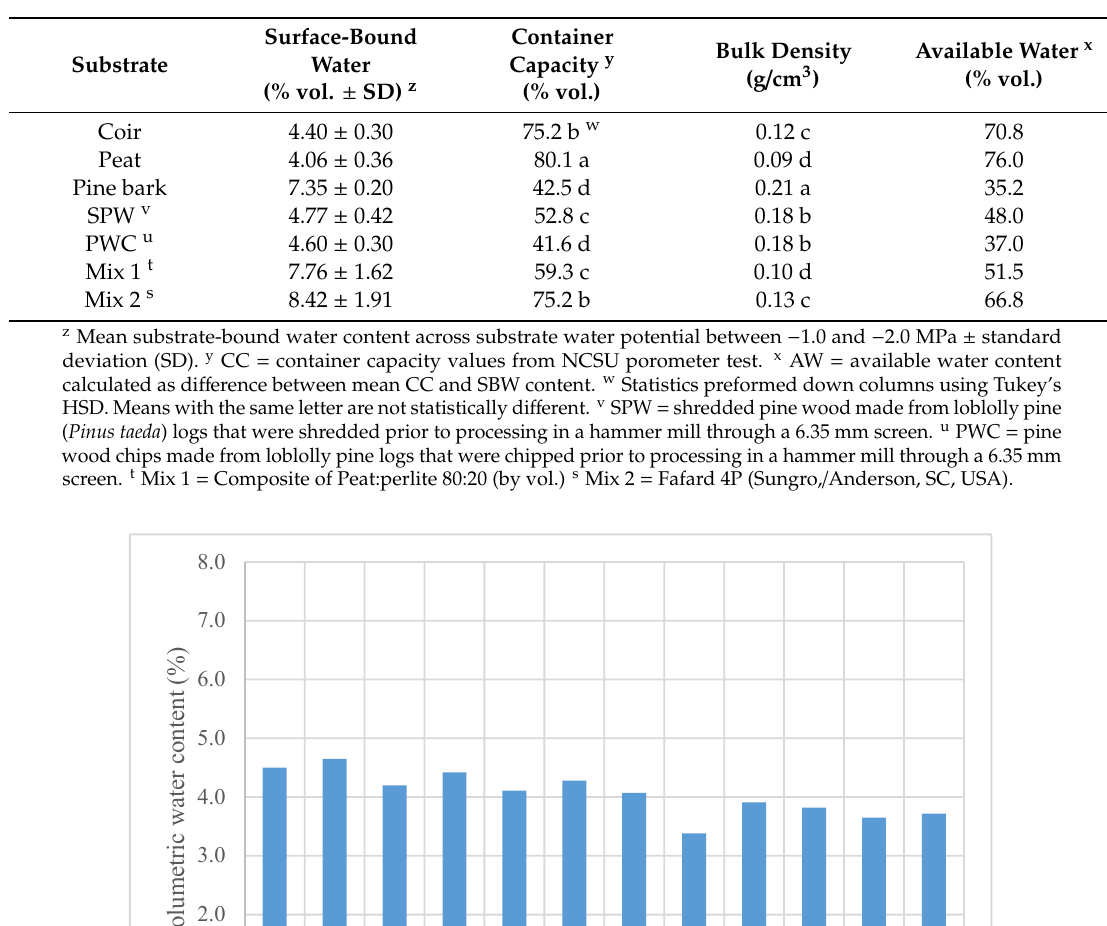
Table 1. Estimated substrate-bound water contents, container capacity and available water for substrate components and composites determined via dewpoint hygrometry measured between − 1.0 and − 2.0 MPa.